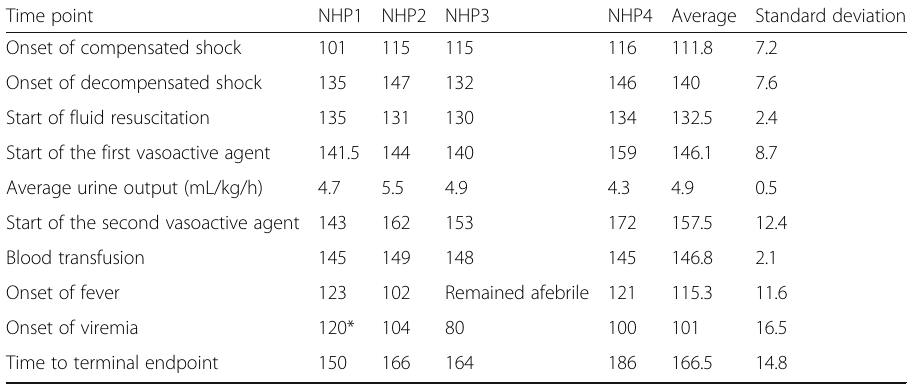
Table 1 Important experimental time points Time